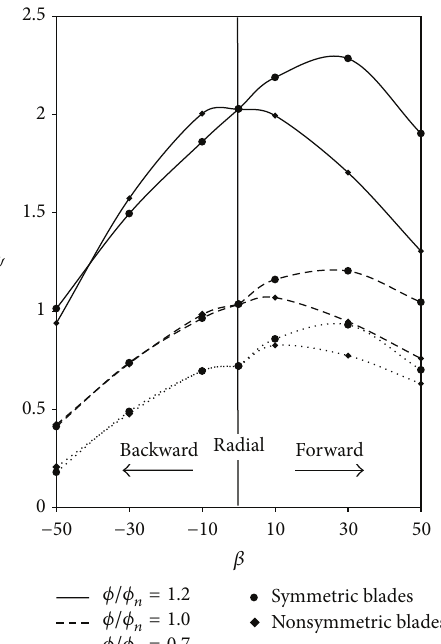
Figure 18: Comparison of head coefficients between all types of impellers with different blade angles at 𝜙/𝜙 𝑛 = 0.7 , 𝜙/𝜙 𝑛 = 1 , and = 1.2 . 𝜙/𝜙 𝑛